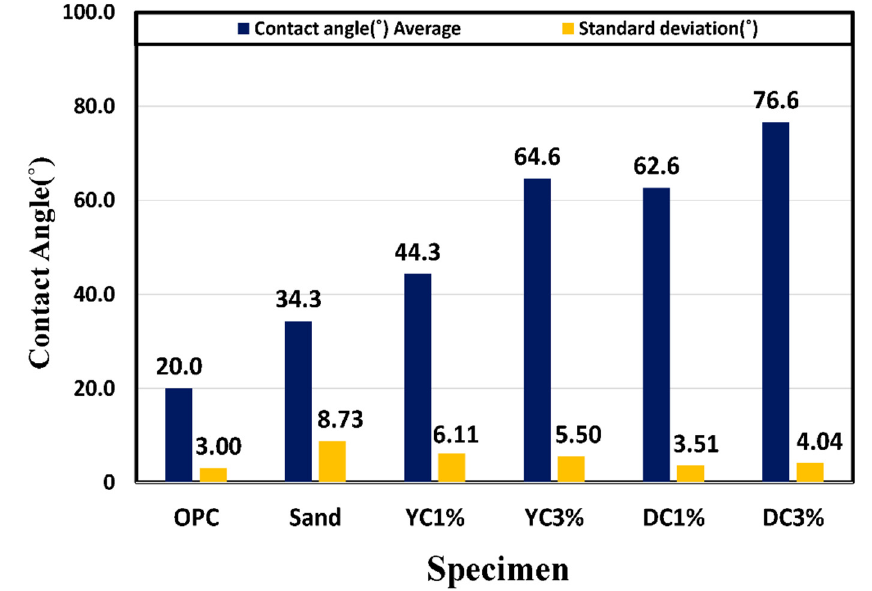
Figure 10. Measurement of contact angle (°) (91 d).